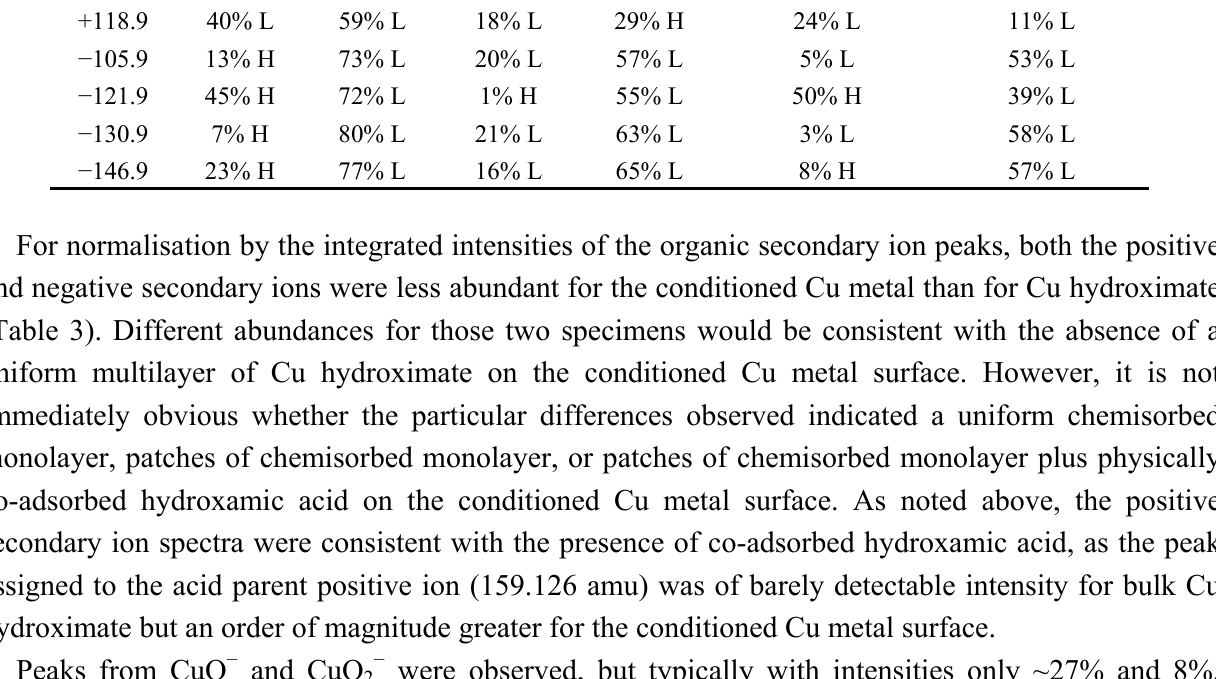
Table 3. Intensities of Cu-containing diagnostic secondary ion peaks from conditioned surfaces of Cu metal, malachite and pseudomalachite compared with those from bulk Cu hydroximate (L: lower, H: higher); for each surface, peak intensities have been normalised relative to the intensities of both Cu ion and organic fragment ion peaks as in Tables 1 and 4. Oxide surface/normalisation Peak m/z Malachite/ Malachite/ Pseudomalachite/ organic